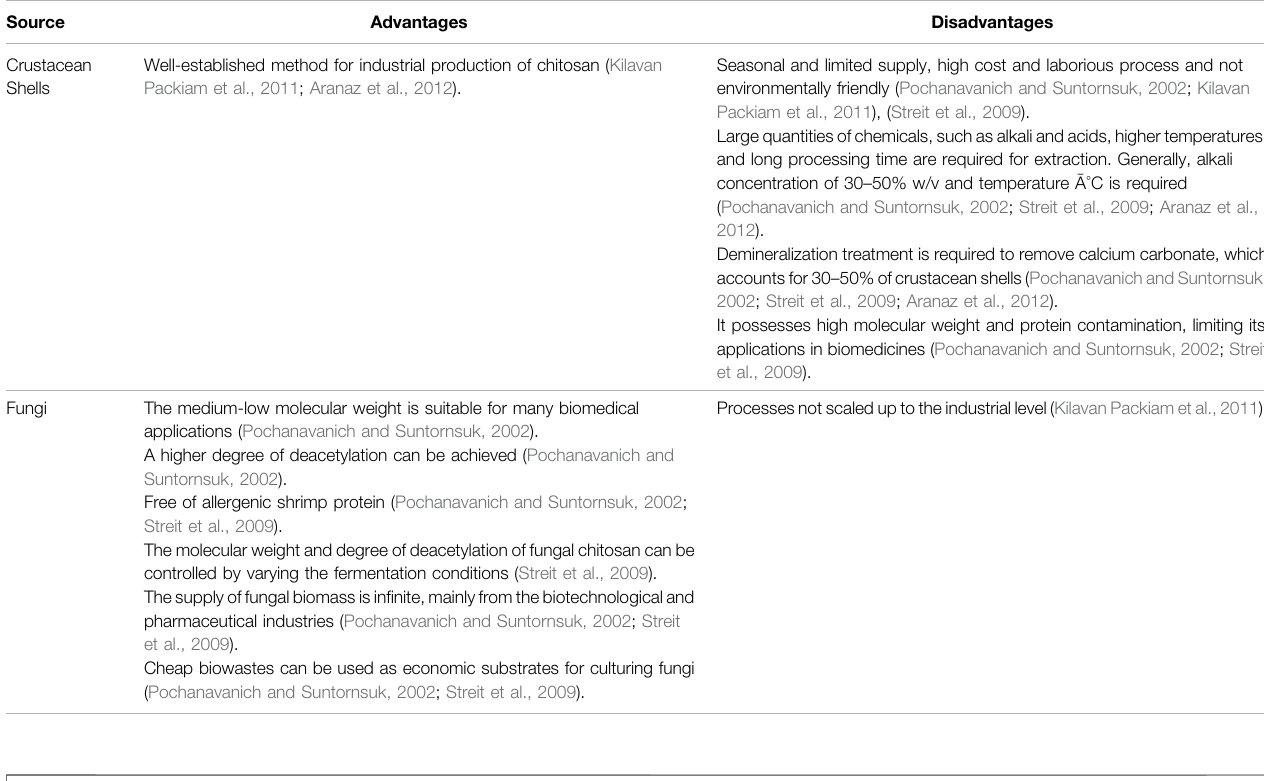
TABLE 1 | Advantages and disadvantages of chitosan from crustacean shells and fungi. Source